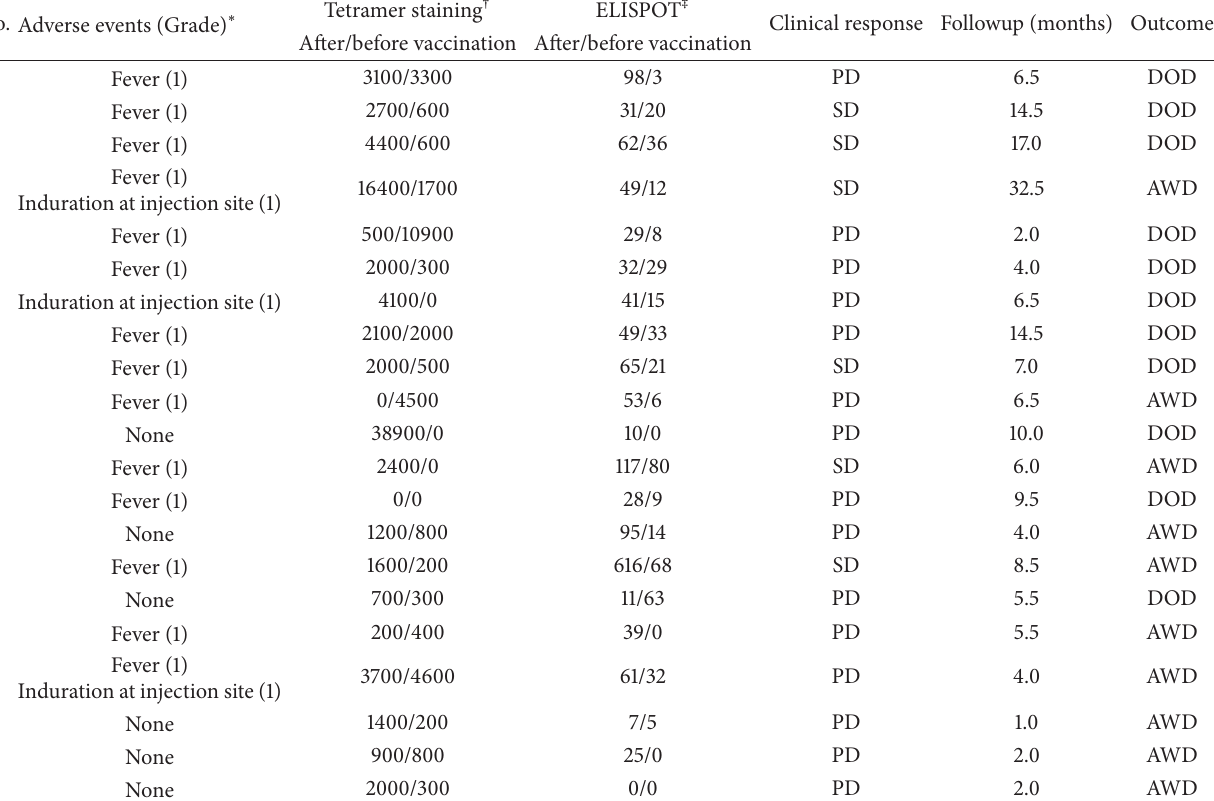
Table 2: Summary of clinical and immunological responses to vaccination with survivin-2B80-88 peptide, IFA, and IFN